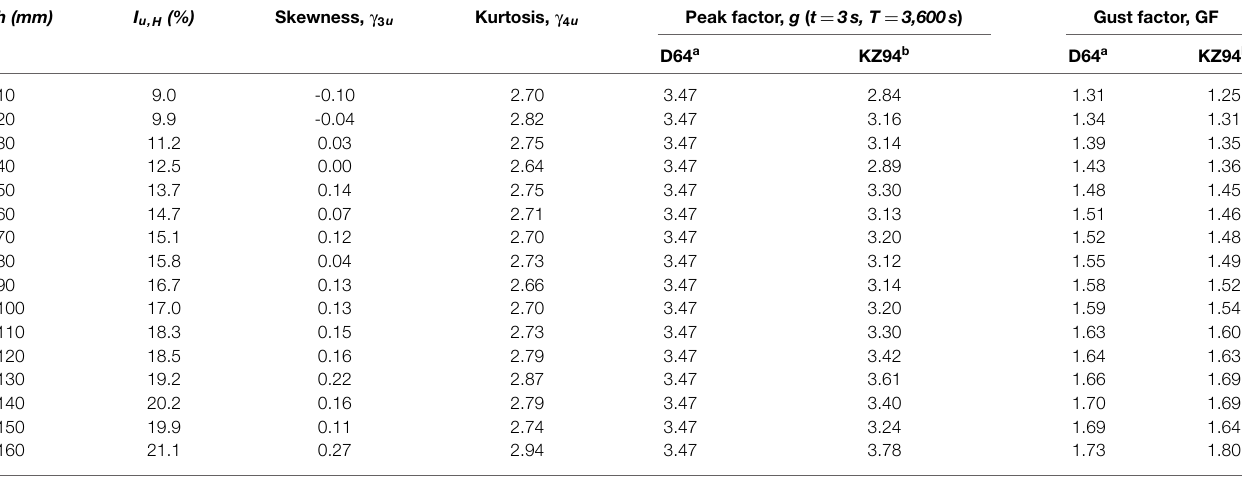
TABLE 5 | Gust factor estimates based on turbulence levels at eave height (narrow